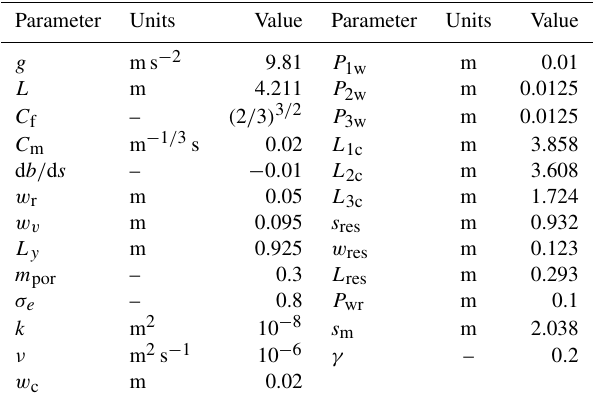
Table 2. Parameters: units and values used. Note that α = k/(m por νσ e ) and γ ∈ [ 0, 1 ] .